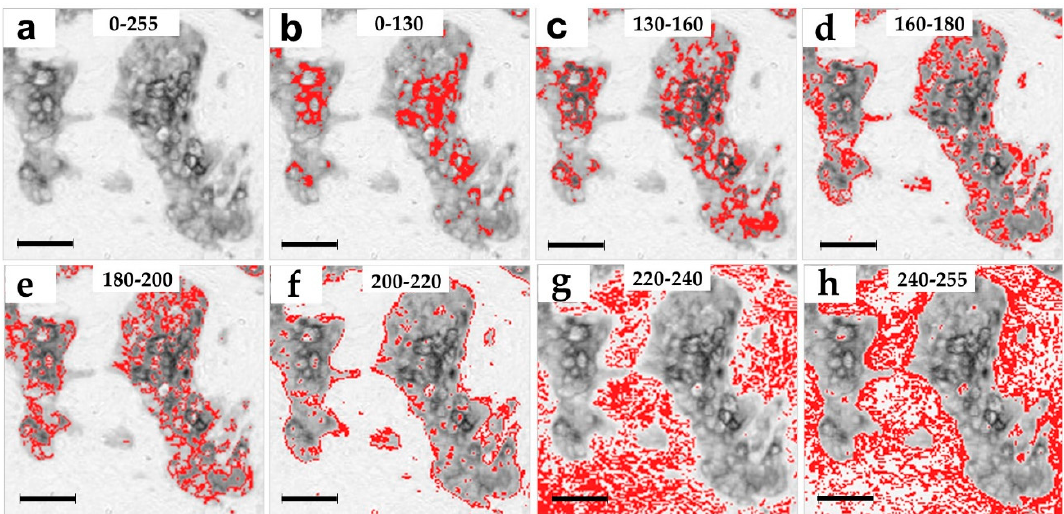
Figure 2. Spatial distribution of the pan cytokeratin staining intensities. ( a ) Magnification of the exemplary original image of pan cytokeratin staining with the full 0–255 pixel intensity range, ( b ) the original image overlaid with red pixels indicating the staining patterns in the highest intensity range of 0–130 and the moderate intensity ranges: ( c ) 130–160, ( d ) 160–180, ( e ) 180–200, and the low intensity ranges of ( f ) 200–220, ( g ) 220–240, and ( h ) 240–255. Magnification: ×320. Pixel size: 1.8 µm. Bar 50 µm, indicated in images ( a–h ).